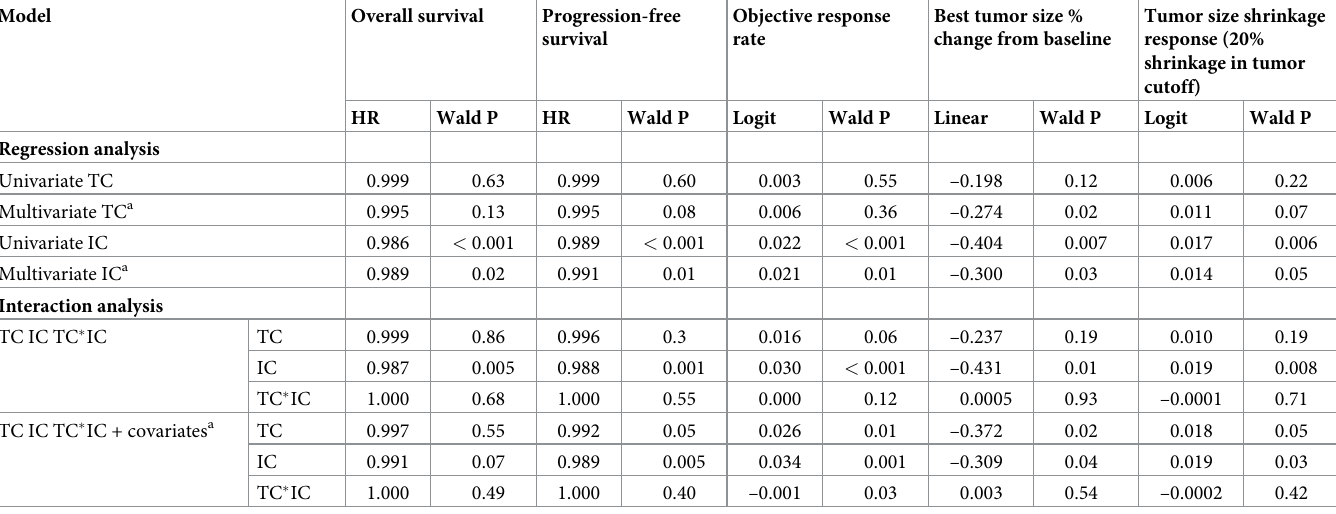
PFS was also prolonged for PD-L1–high compared with PD-L1–low patients when samples were categorized using CPS � 10 and IC � 5%. Of particular note, the TC � 25%/IC � 25% cutoff appeared to be optimal for separating responders from nonresponders in the PD-L1– low population. This contrasts with the IC � 5% cutoff, which although enriching for response in patients with PD-L1–high expression, included a substantial (14%) proportion of respond- ers with PD-L1–low expression. CPS � 10 proved to be a less effective predictor of response Table 2. PD-L1 biomarker regression and interaction analyses in the 1108 study. Model